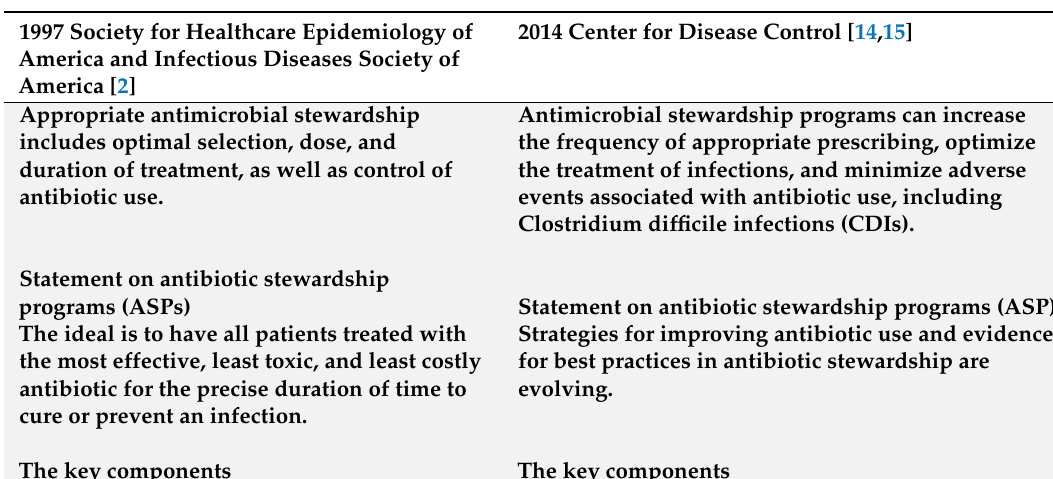
Table 1. The evolving definition of antibiotic